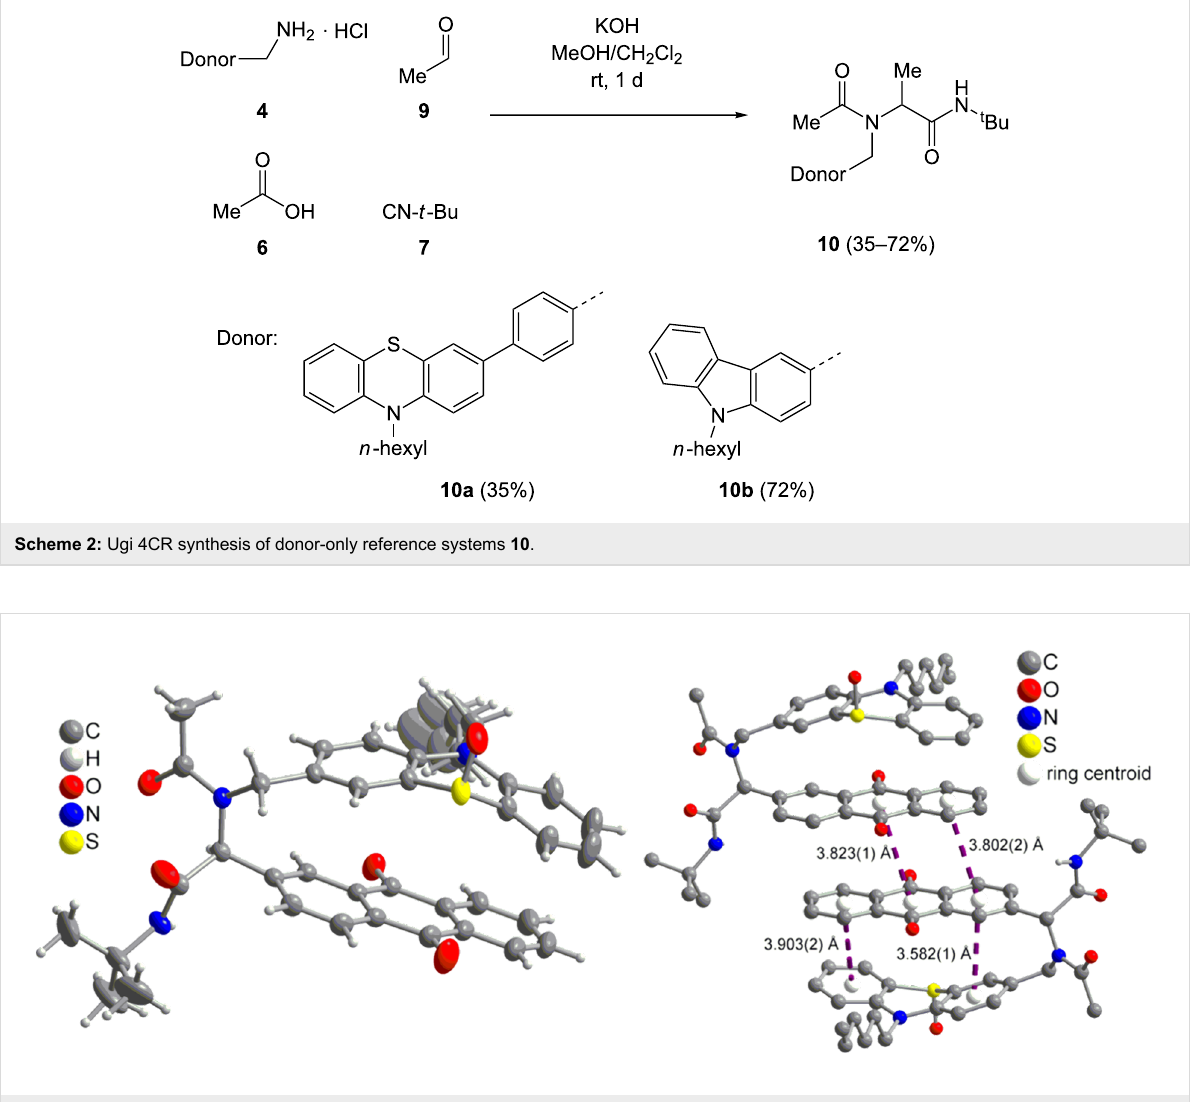
Figure 2: Molecular structure of S(O)- 1 (left) (30% ellipsoids, except for the CH 3 CH 2 end of the hexyl group, the disordered water molecules were omitted for clarity) and the intra- and intermolecular π – π -stacking interactions between an inversion symmetry related pair (right, hydrogen atoms were omitted for